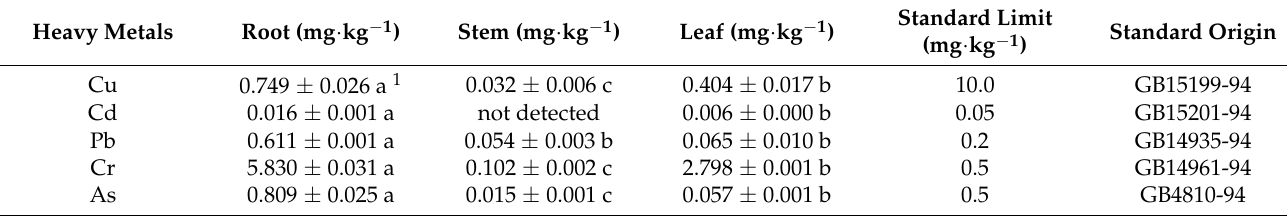
Table 3. Content of heavy metals in different organs of water dropwort and Chinese National Food Sanitation Standards for heavy metals in